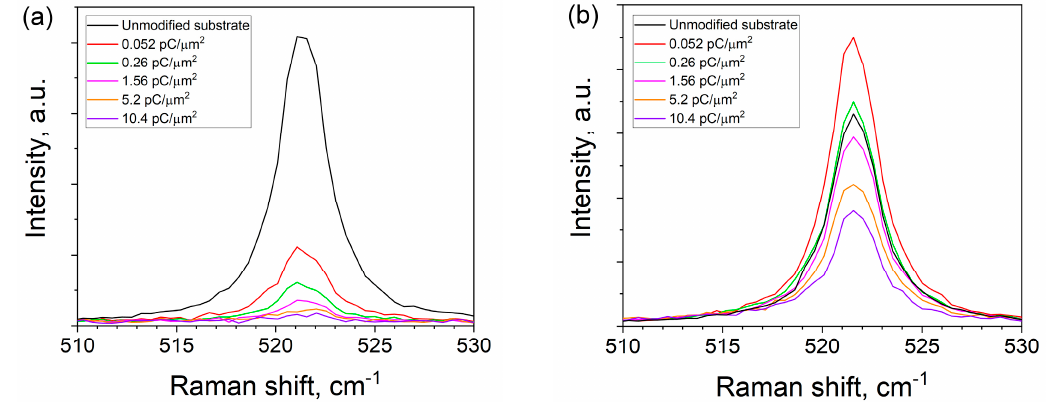
Figure 5. Raman spectra of substrate areas with different ion dose before ( a ) and after ( b ) UHV annealing.